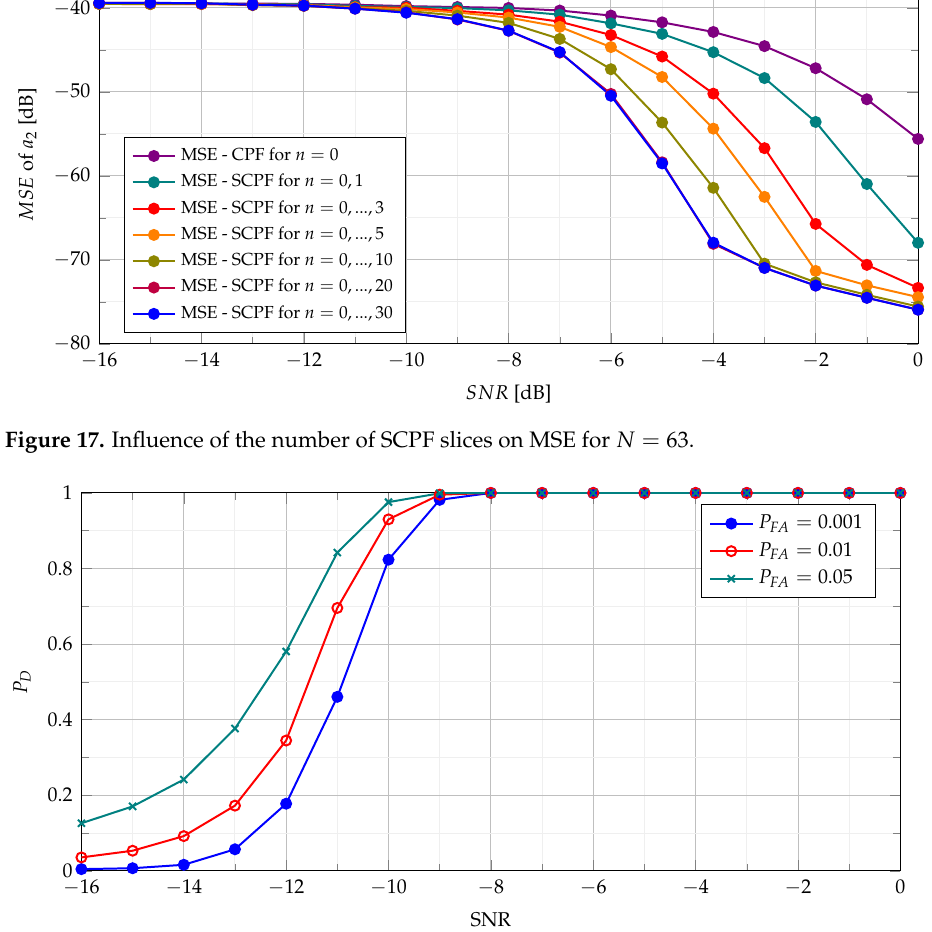
Figure 19. Probability of detection with use of the TSCPF statistics employing slices n = { 0, . . . ,30 } for N = 63. The comparison of results presented in Figure 19 for P FA = 0.01 and results presented in [29] indicates that detector based on the TSCPF statistics outperforms detector based on the TICPF statistics. It should be noticed that the detection algorithm from [29] uses 64 slices whereas the algorithm proposed in the paper only 31 slices. Moreover, as can be seen in Figures 6, 10, 18 and 19 detection achieves better efficiency with increasing number of signal samples and with increasing number of slices. The extended comparison of the obtained results with results from the literature, which apply both selected time-frequency (T-F) methods and selected time-frequency rate (T-FR), is presented in the Table 1. The SNR threshold was selected as an evaluation method. As can be seen in the Table 1, the proposed detection and estimation methods show the significantly lower SNR threshold than other algorithms used for detection and estimation of LFM signals.